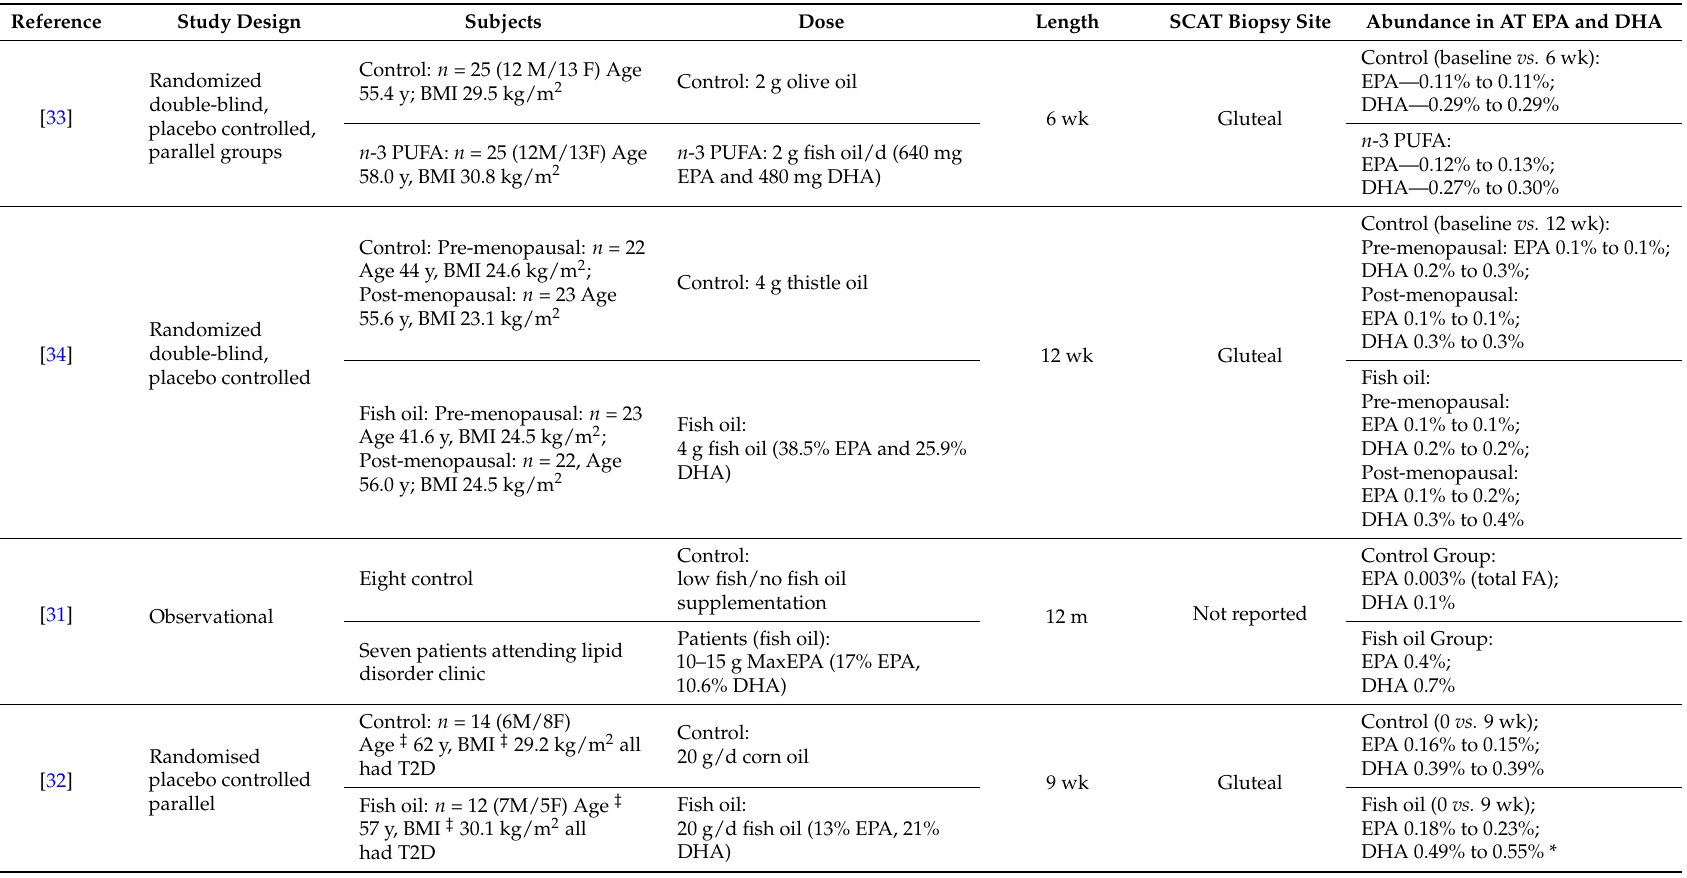
Table 1. Overview of human studies investigating change in eicosapentaenoic acid (EPA) and docosahexaenoic acid (DHA) abundance in subcutaneous adipose tissue.